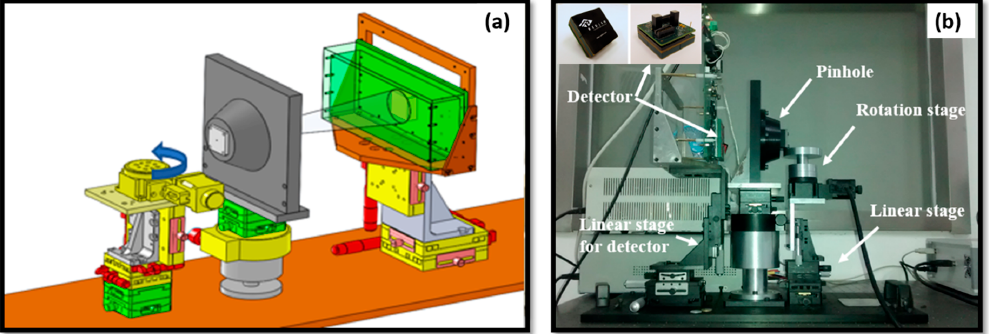
Figure 4. ( a ) Schematic diagram of the pinhole SPECT system design, which consists of rotary stage, collimator and CZT detector; ( b ) Close-up of the pinhole SPECT system.